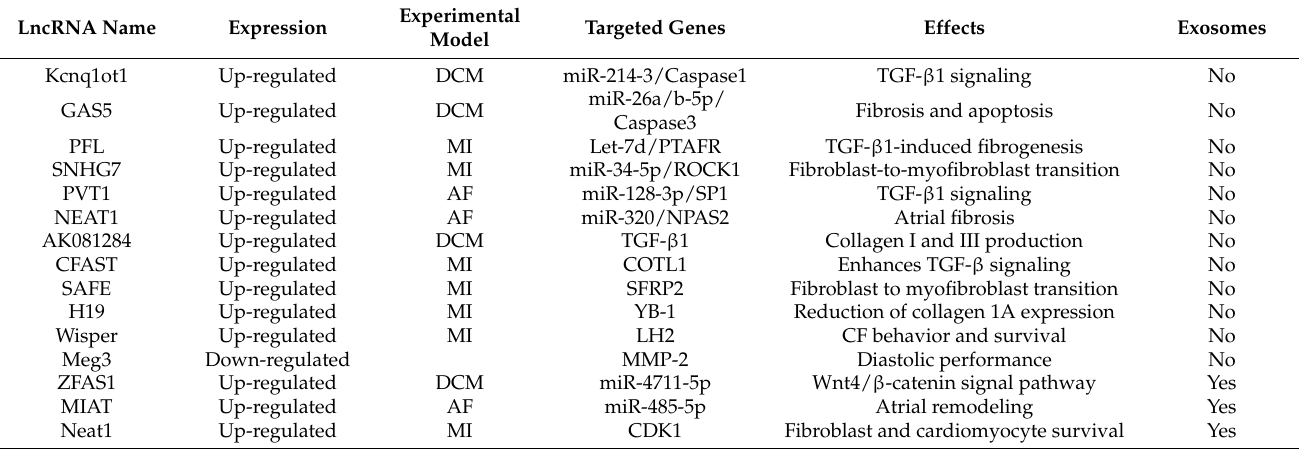
Table 1. The functions and mechanisms of lncRNAs in cardiac